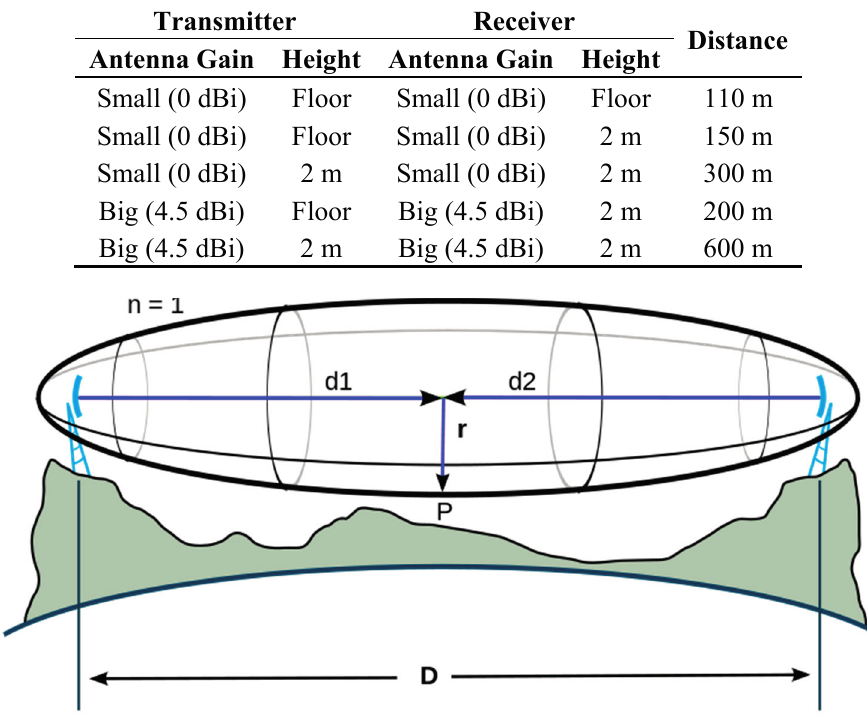
Figure 14. Fresnel zone.